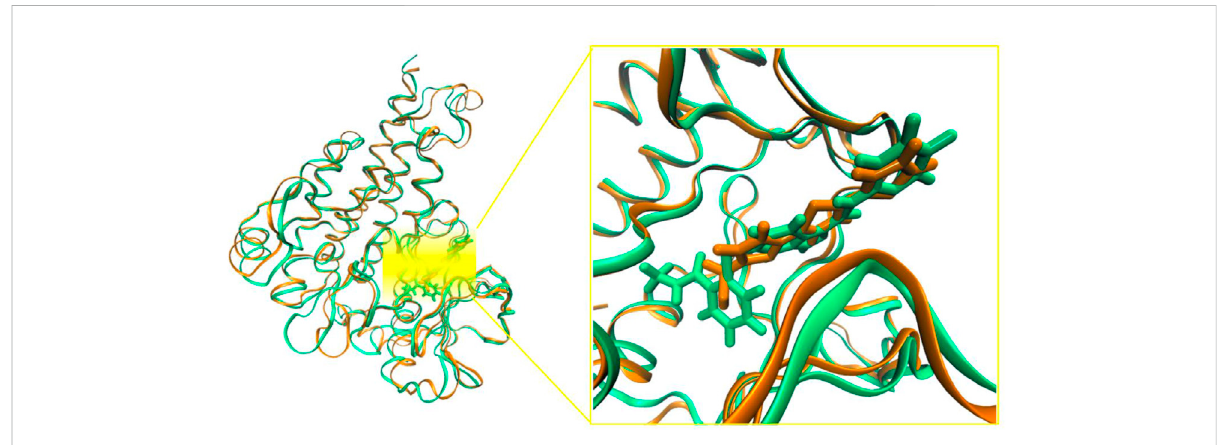
Table 2. The cavity occupied by 3 in the latter involved the hydrophobic residues L348, V356, A369, L394, T404, M420, Y422, G425, M473, and A483, and the charged L371. All